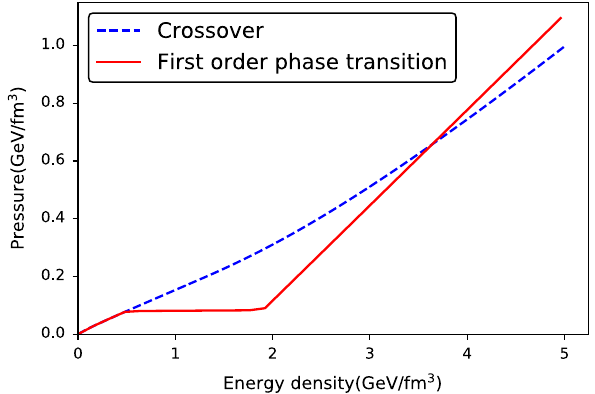
Fig. 1 Two different EoSs are implemented in the hydrodynamic sim- ulation, as functions of the energy density. A crossover, based on a lat- ticeQCDparametrizationiscomparedwithafirstorderphasetransition with a transition temperature T c = 165 MeV, obtained by a Maxwell construction. It is assumed that the baryon-chemical potential is exactly μ = 0 throughout the whole B